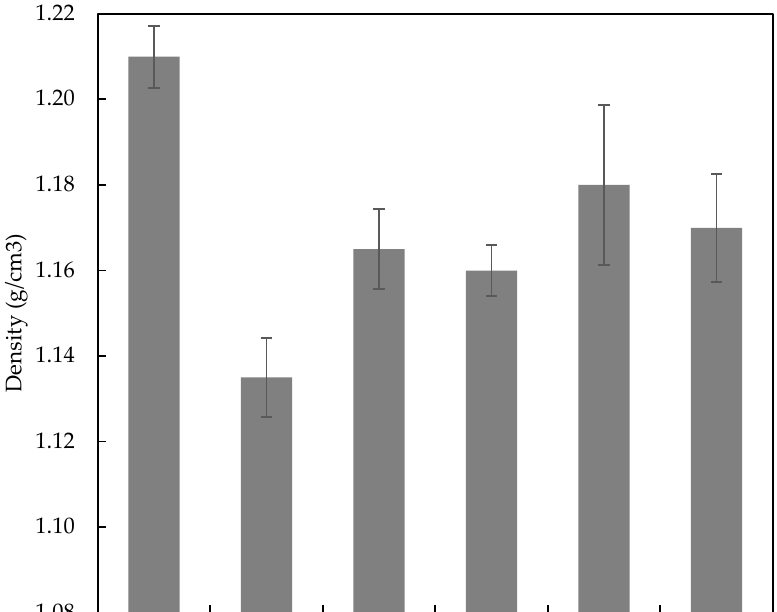
Figure 3. Density plots for PALF/Kevlar-reinforced UP hybrid composite laminates with different stacking sequences.